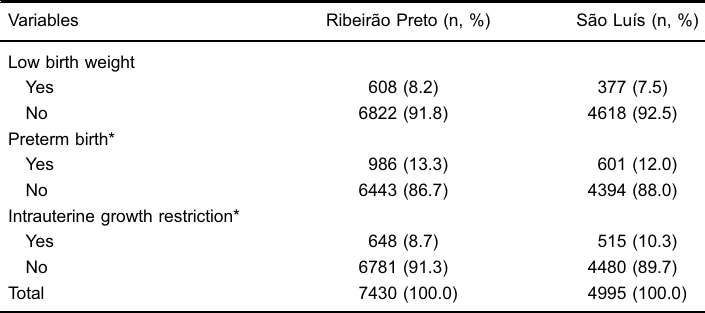
Table 1. Perinatal outcomes in Ribeirão Preto and São Luís birth cohorts (2010). Variables Ribeirão Preto (n,